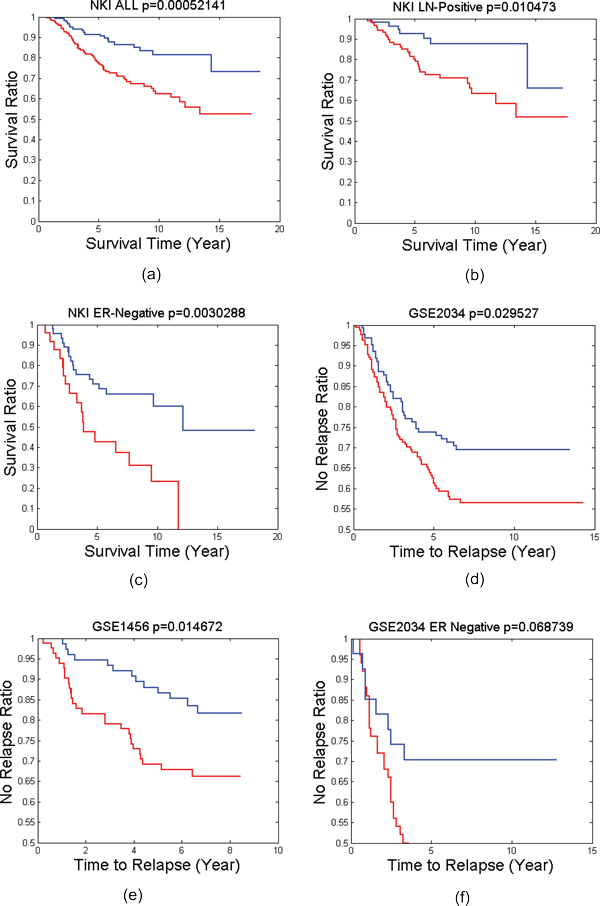
Survival tests of the UBC network. The survival results of UBC Network (containing genes "UBC, DAP, CPS1, GUCY1A2, TPTE/TPTE2, NDUFS6, SDHA, NUDT21, HAUS6, PGAM2") on (a) All patients in NKI dataset (b) LN-Positive patients in NKI dataset, (c) ER-Negative patients in NKI dataset, (d) All patients in GSE2034 datasets, (e) All patients in GSE1456 dataset, (f) ER Negative patients in GSE2034 dataset. Blue lines are the survival curves of good survival groups. Red lines are the survival curves of poor survival groups.